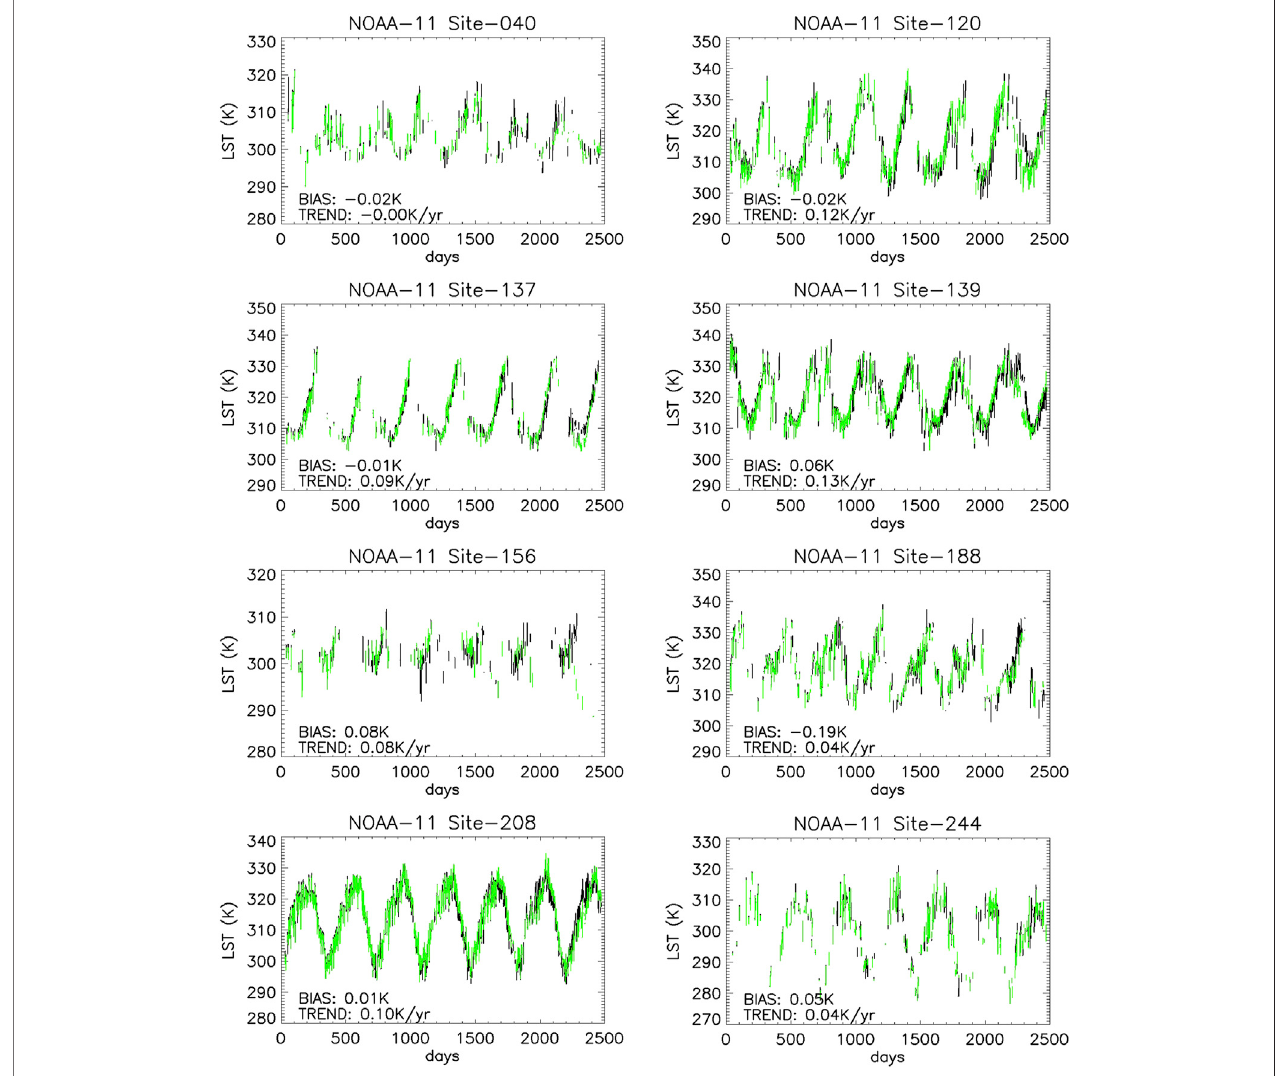
FIGURE 5 | Corrected time series for NOAA-11 platform for eight selected sites: reference (black) and ideal case corrected (green) time series along with the resulting bias and trend difference statistics.